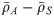
Cooperation experienced distributions for both phenotypes.Each dot represents the expected cooperation experienced for each individual according to their phenotype. The difference in the average of these distributions (ρ-A-ρ-S) is equal to the regression of cooperation experienced on cooperation expressed. In case (A), cooperators interact with other cooperators more often than non-cooperators on average (P1 > 0). In case (B), cooperators interact with other cooperators just as often as non-cooperators on average (P1 = 0); therefore, the slope of the regression is zero, though the variance in cooperation experienced is not zero (Pv > 0).